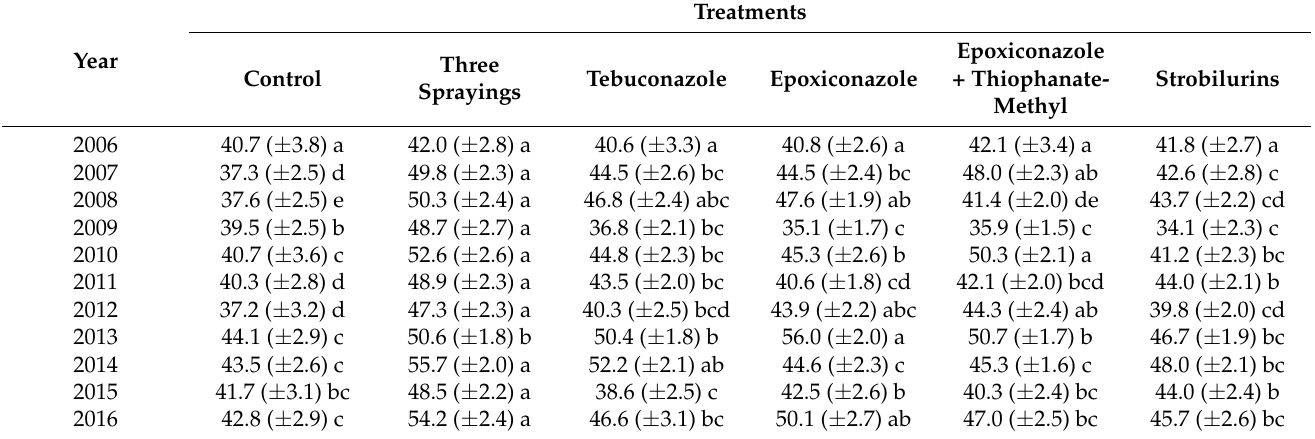
Table 7. Yield of sugar beet leaves (t ha − 1 ) in the study years ( ± SD), by fungicidal protection method.